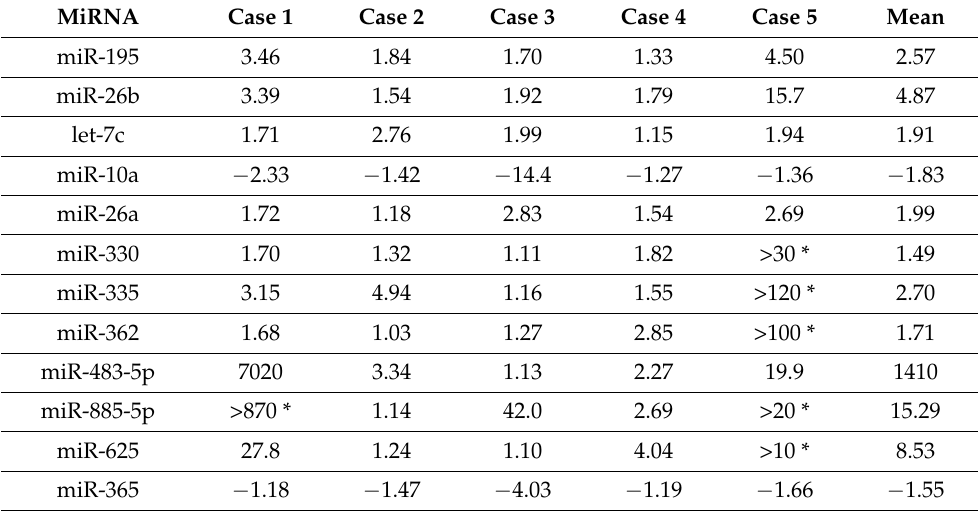
Table 1. A total of 12 different miRNAs were consistently up-regulated or consistently down- regulated in breast cancer cells after neoadjuvant chemotherapy in 5 cases of estrogen receptor positive breast cancer. Cancer cells were isolated by laser capture microdissection from matched samples of pre- and post-neoadjuvant chemotherapy (NAC) breast cancer tissue. qPCR arrays were used to quantify the relative expression of 377 different microRNAs. Fold differences in post-NAC expression relative to pre-NAC are shown for each cancer case, along with the mean fold difference. * denotes fold differences that were estimated when the miR was not detected in one of the paired samples; the estimation is based on defining expression in this sample as the theoretical limit of detection (i.e., a cycle threshold of 40); these estimates were excluded from the assessment of